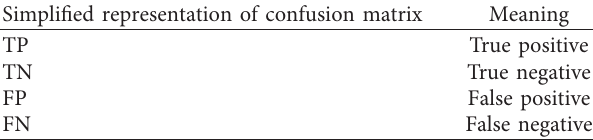
Table 1: Confusion